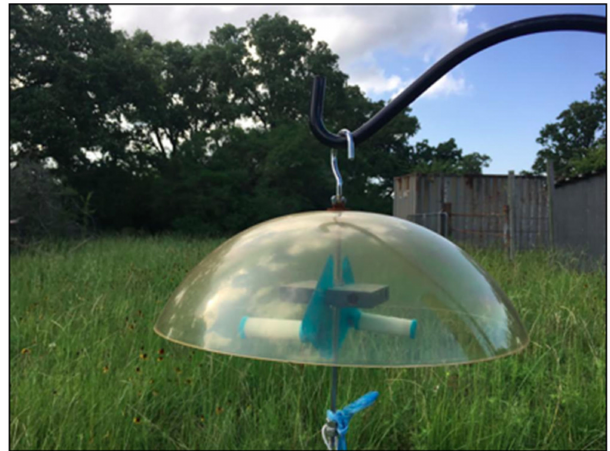
Figure 1. Sampling setup with Radiello di ff usive bodies under the protective shelter.